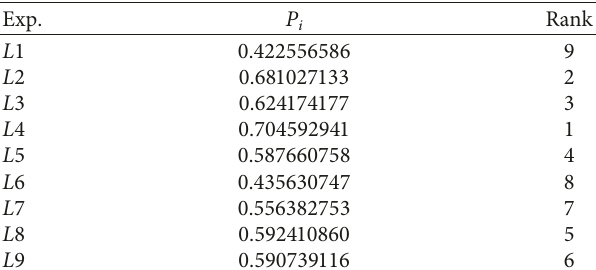
Table 11: Ranking of the performance matrix. Exp.